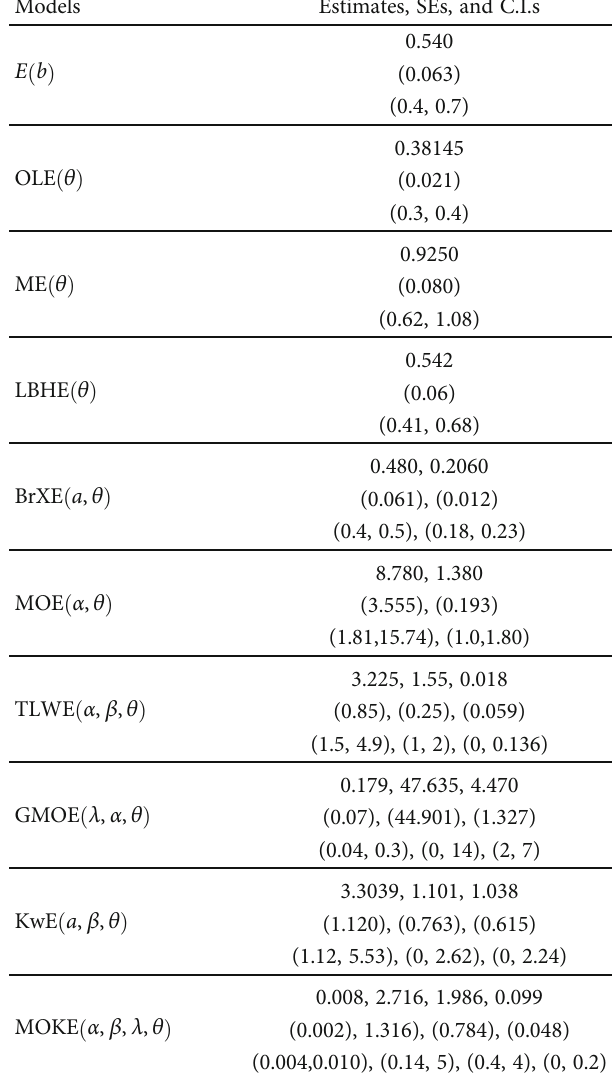
Table 3: MLLEs, SErs, and C.I. (in parentheses) values for the survival time data. Models Estimates, SEs, and